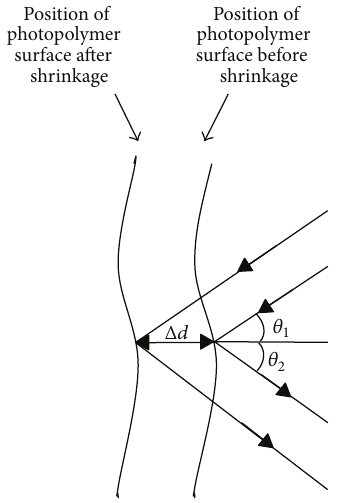
Figure 3: Illustration of change in optical path due to shrinkage.